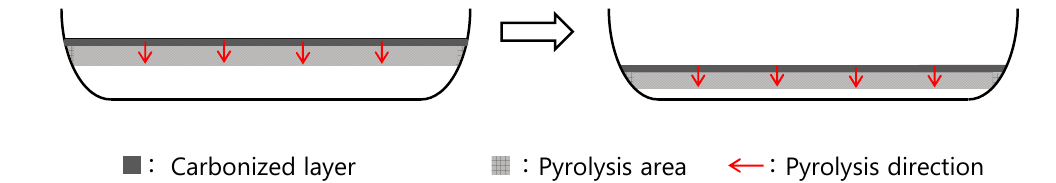
Figure 13. A diagram showing the progression of the fast pyrolysis of Avicel cellulose powder in a quartz boat in response to IR irradiation.